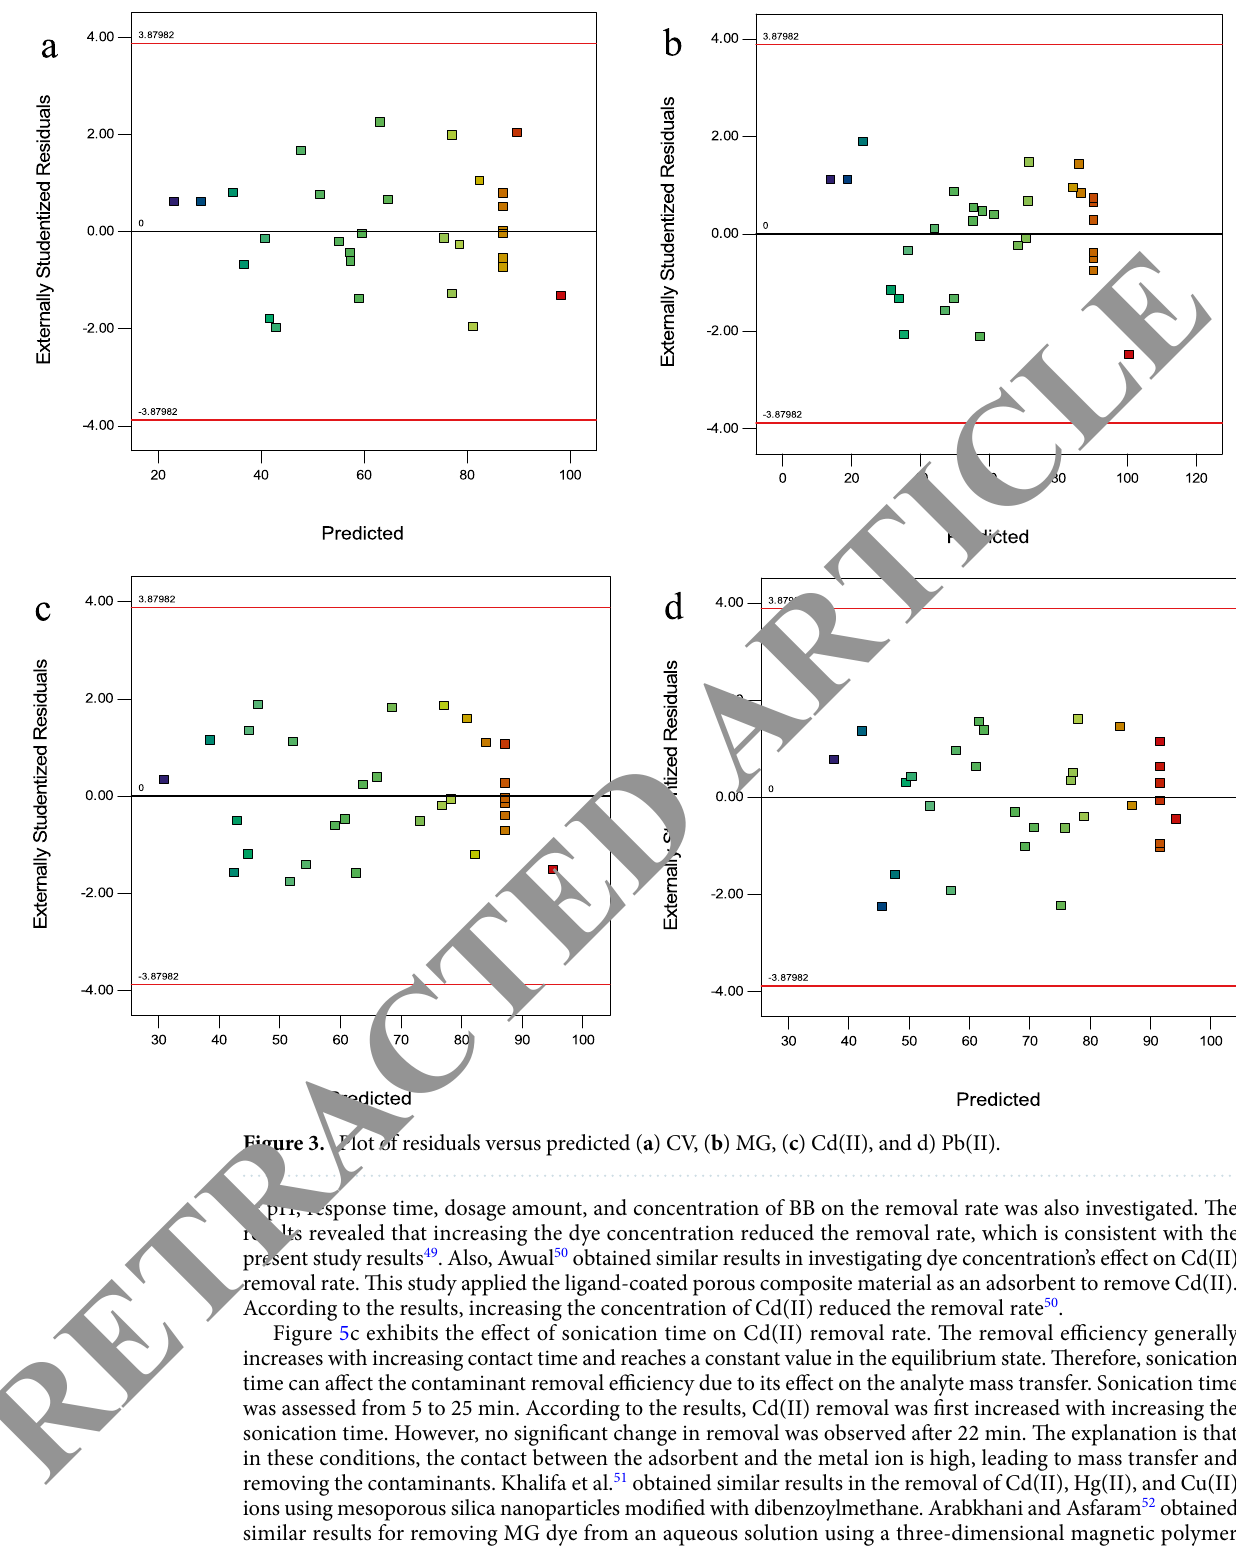
Figure 3. Plot of residuals versus predicted ( a ) CV, ( b ) MG, ( c ) Cd(II), and d)